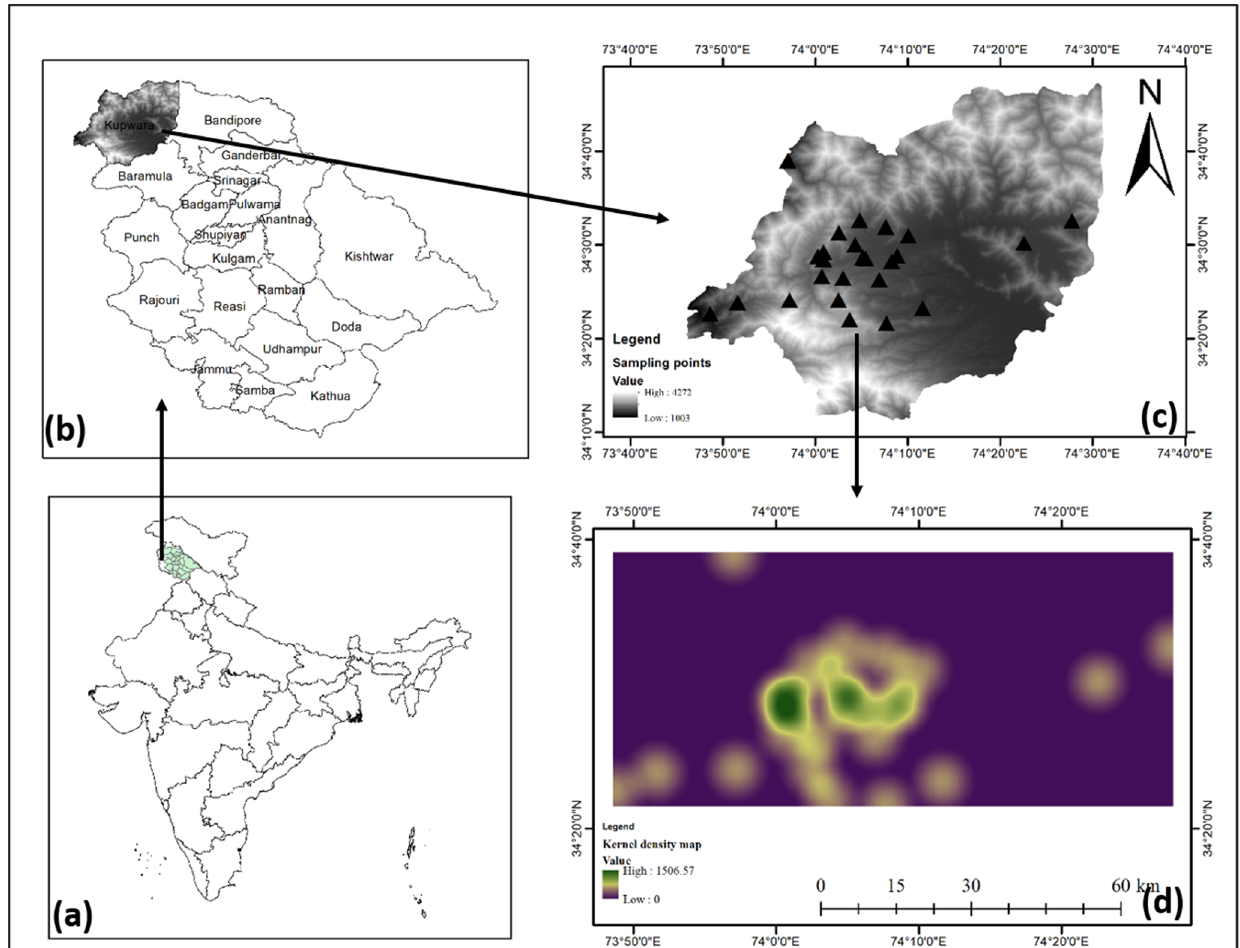
Figure 1. ( a ) Map of India, ( b ) map of Jammu and Kashmir, ( c ) map showing surveyed villages in the District of Kupwara, and ( d ) Kernel density map of the sampled villages.